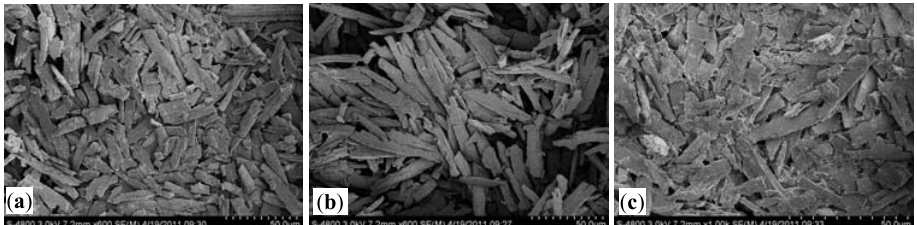
Figure 5. Morphology of struvite precipitation at different pH: ( a ) pH = 8 ( b ) pH = 9 ( c ) pH =